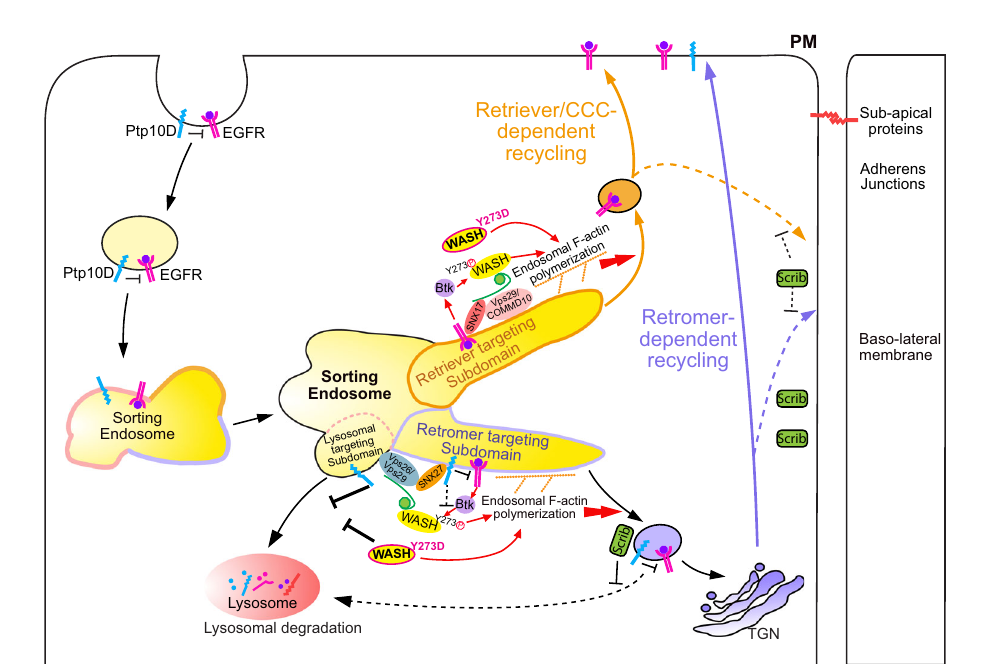
Fig. 5 | A proposed modelfor differential recycling routes ofPtp10D and EGFR in epithelial tissues. In the sorting endosomes, EGFR and Ptp10D located into differentsubdomainsandfollowbifurcatedrecyclingroutes.Ptp10Disrecycledby the WASH/retromer complex while EGFR is predominantly recycled by the WASH/ retriever/CCC complex. The ef fi ciency of these recycling routes is regulated by